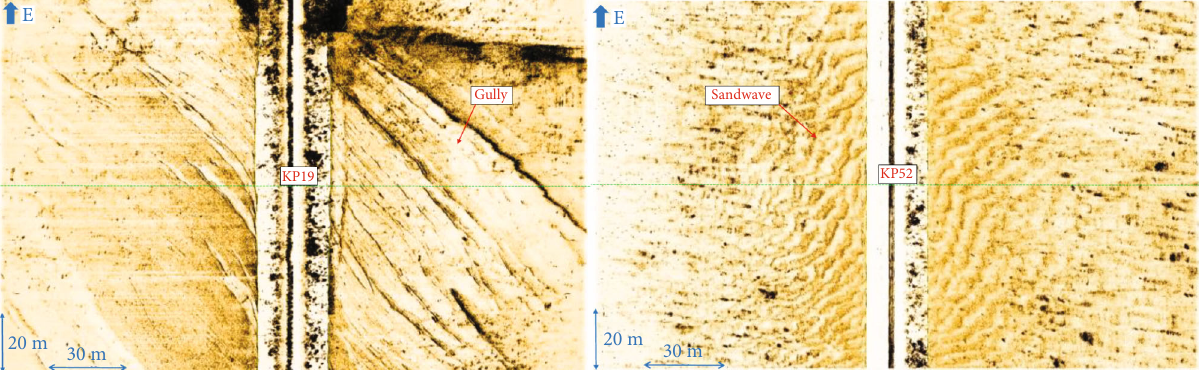
Figure 4: Microscouring and sandwave geomorphology of the Yangtze River subaqueous delta showed by side-scan sonar (left is scouring gully, and right is